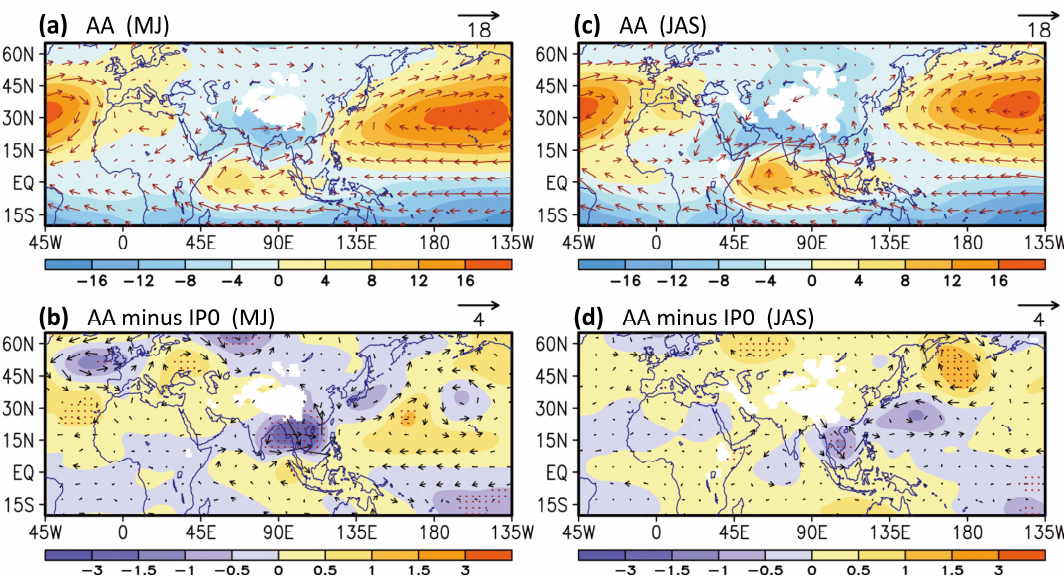
Figure 11. The 850–hPa streamfunction (10 6 m 2 s −1 ; shading) and wind (m s −1 ; vectors) of ( a ) AA simulation in May–June; ( b ) AA minus IP0 simulation in May–June; ( c ) IP0 simulation in July–September; and ( d ) AA minus IP0 simulation in July–September. Vectors in ( a , c ) denote wind speeds higher than 3 m s −1 and in ( b , d ) denote wind speeds higher than 0.5 m s −1 . Dots denote that the differences in streamfunction have a confidence level of 90%.